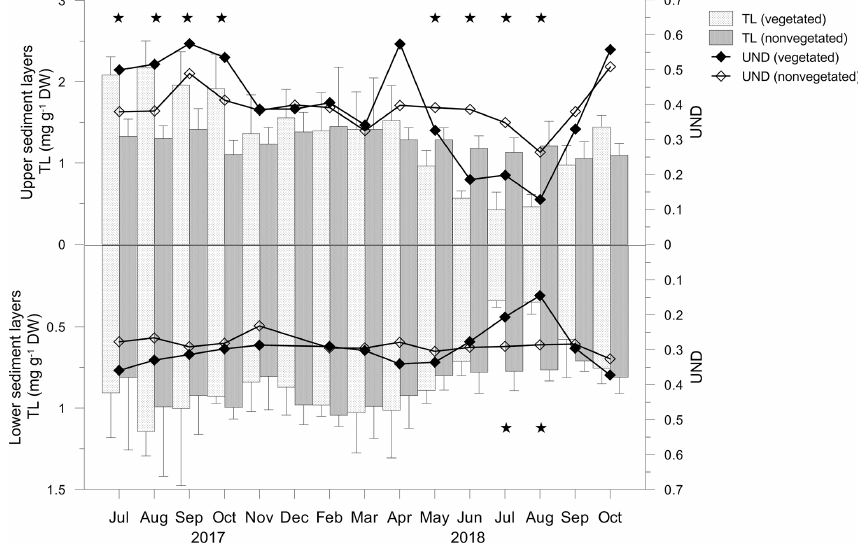
Figure 9. Total lipid concentrations (TLs) and unsaturation degree (UND) in the upper (0–4cm) and lower (5–8cm) layers of vegetated and nonvegetated sediments. Significant differences in TLs between the sediments are indicated by